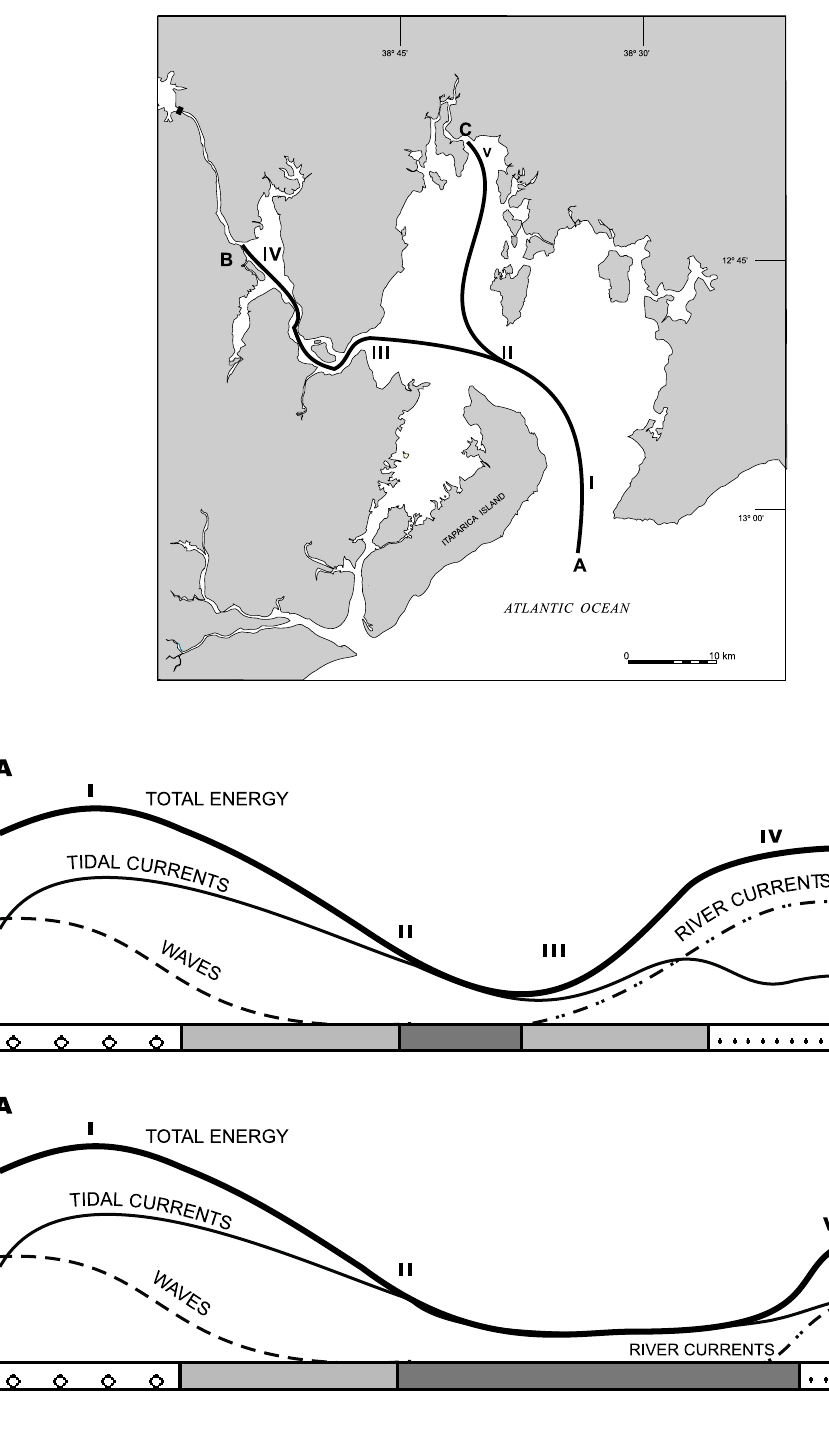
Fig. 11 – Schematic distribution of the energy level and sedimentary facies along the main axis of the TSB and along Paraguaçu Channel and Paraguaçu River. See legend for sedimentary facies in Figure 7.